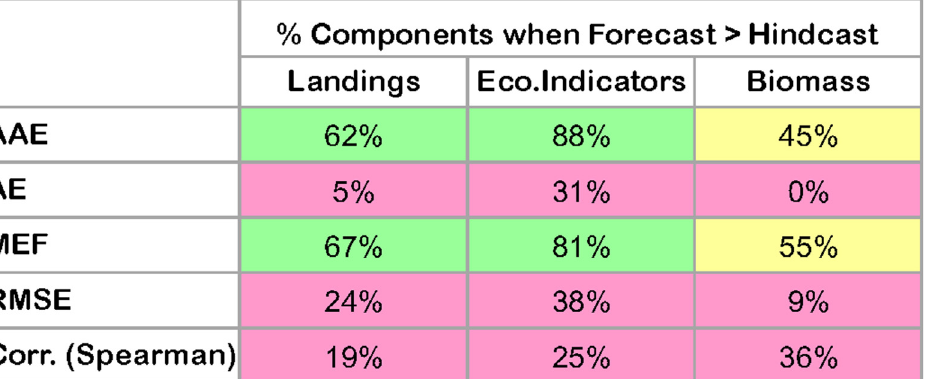
Fig 10. Comparison of model skill performance for hindcast (1974 – 2004) and the model forecast (2004 – 2013) for species biomass or landings and ecosystem indicators. Pink: < 40%, Yellow: 40 – 60%, Green: >